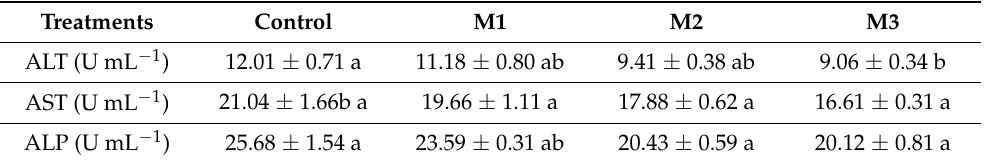
Table 5. Activity of liver enzymes of C. carpio fed a basal diet incorporated with different levels of zero (control), 0.5% (M1), 1% (M2), and 2% (M3) of Myristica fragrans for four weeks. Treatments